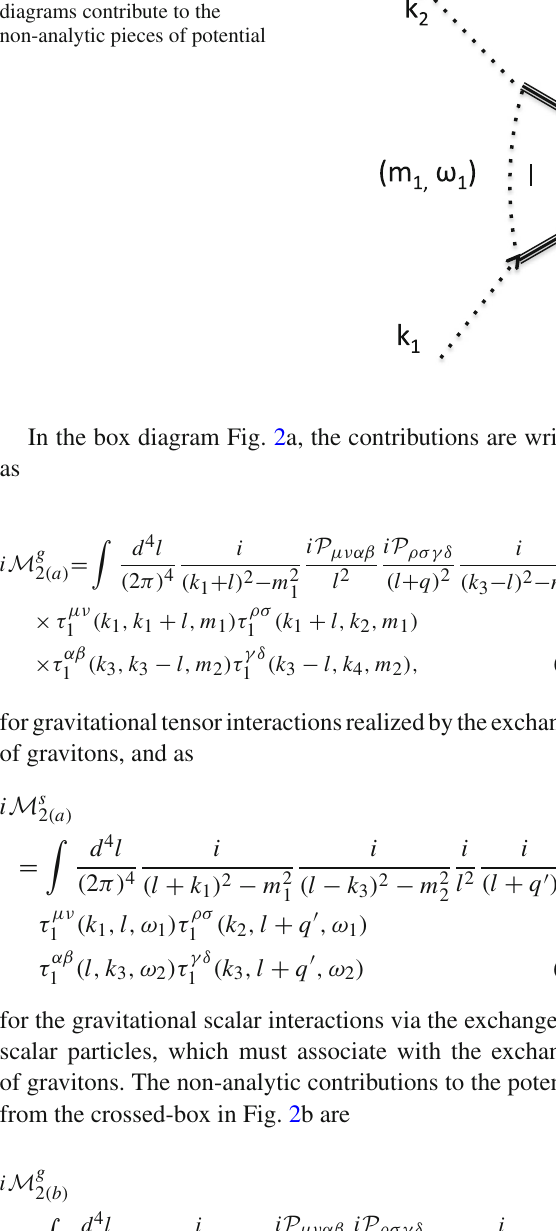
Fig. 3 The set of triangle diagrams contribute to